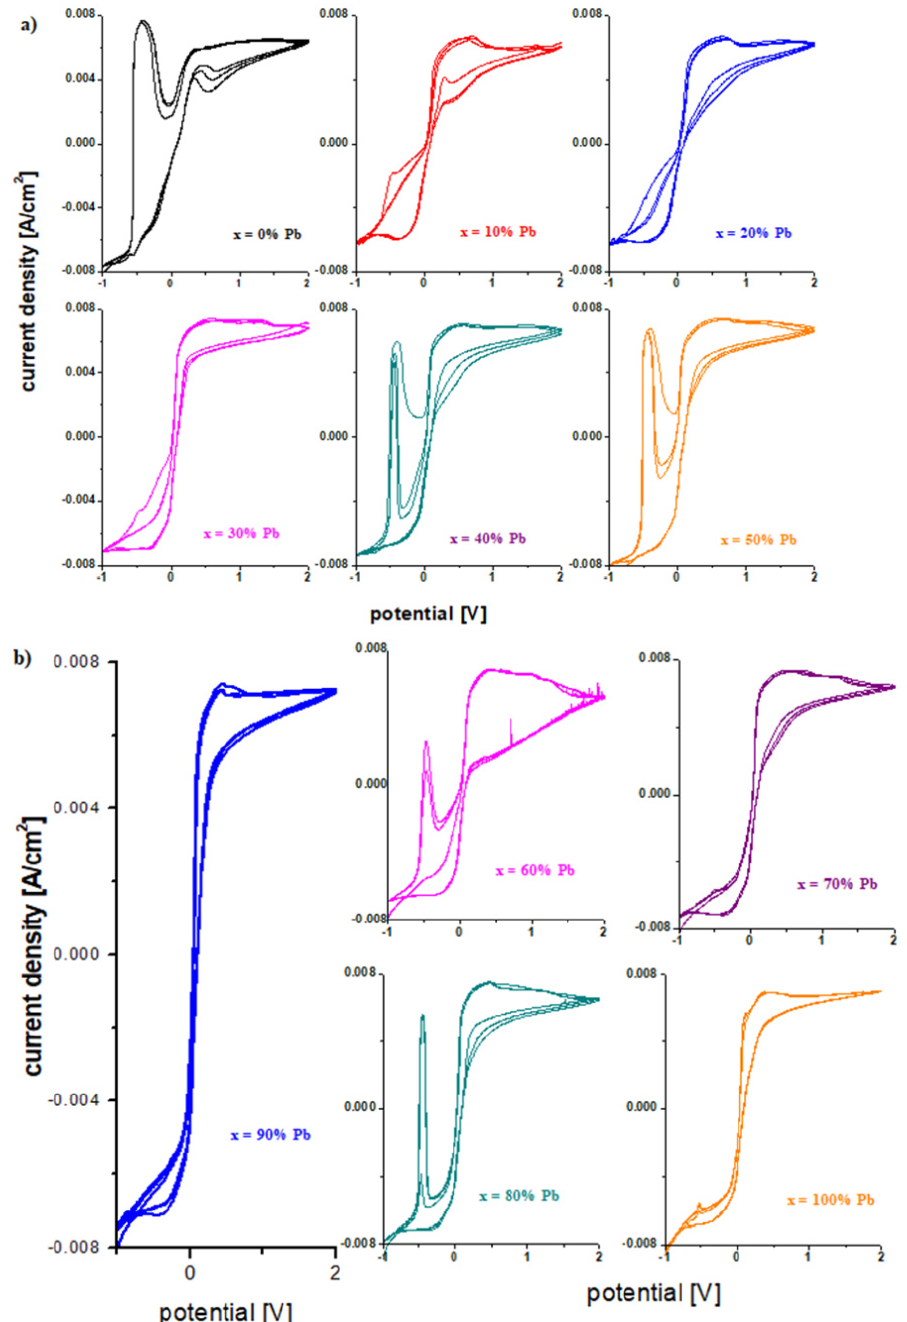
Figure 6. Cyclic voltammograms scanned after three cycles for the vitroceramic system with 15MnO 2 ∙ 85[(100 − x)PbO 2 ∙ xPb] chemical formula where ( a ) x = 0–50 mol% Pb and ( b ) x = 60–100 mol%